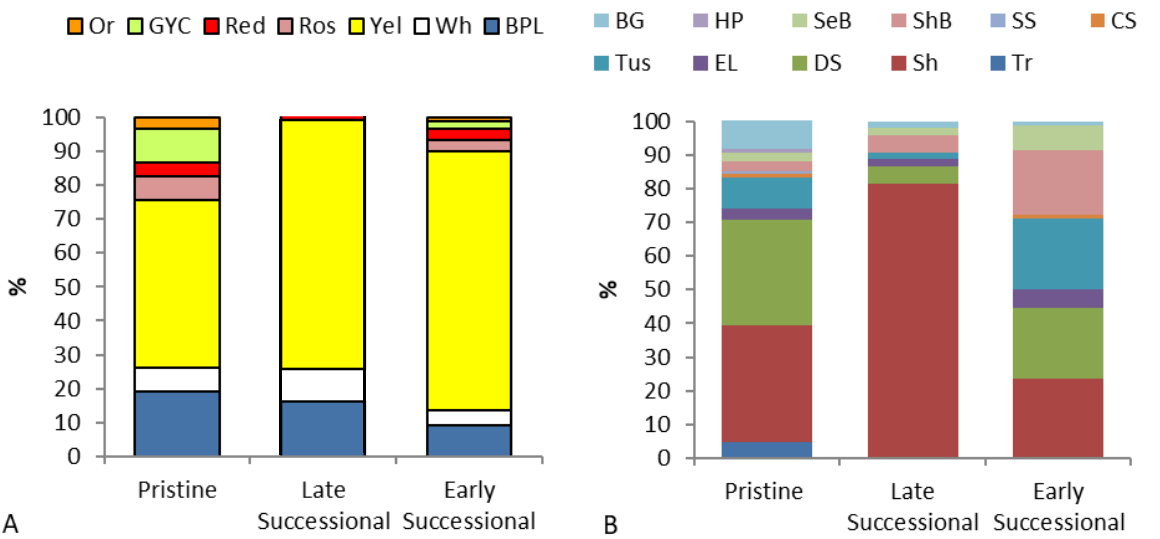
F IGURE 3: A) Proportion of Flower Colours of the Spring Flowering Plant Cover across the three study sites, and B) Proportion of plant growth forms across the three study sites. (Or-Orange; GYC-green/yellow/cream; Ros-Rose; Yel-Yellow; Wh-White; BPL-Blue/Purple/Lilac). (BG-Bare Ground; HP-Hemiparasites; SeB-Semi Basal; ShB-Short Basal; SS-Short Succulent; CS-Climbers & Scramblers; Tus-Tussock; EL-Erect Leafy; DS- Dwarf Shrub (< 0.8m); Sh-Shrub (> 0.8m); Tr-Trees (sensu Cornelissen et al